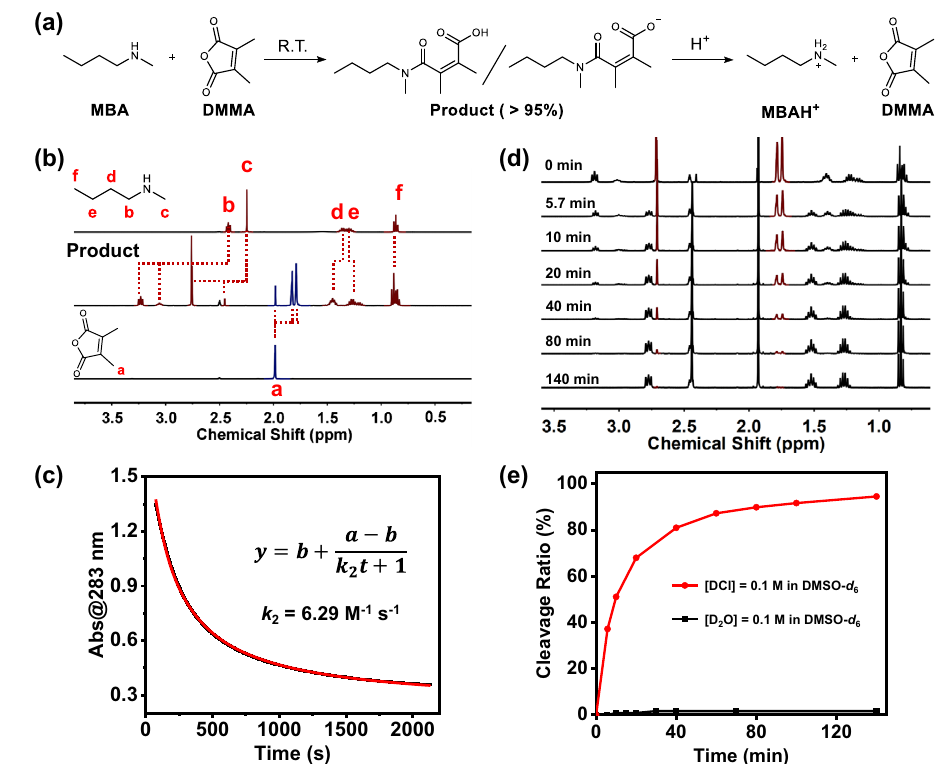
Fig.2|Characterizationofthereversibleamidationreaction.a Schematicofthe modelreactionbetweenMBAandDMMAandthecleavageoftheadditionproduct. b 1 H NMR spectra of MBA (top), the product (middle), and DMMA (bottom) at the concentrations of 0.1M. c Diagram of Abs@283 versus reaction time of 1.0mM